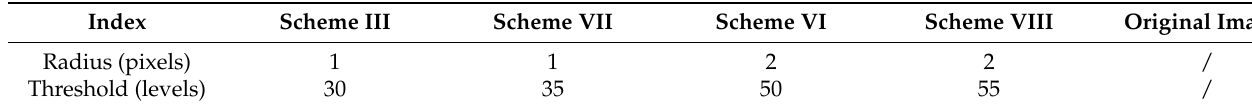
Table 3. Parameter settings in Dust & Scratches .